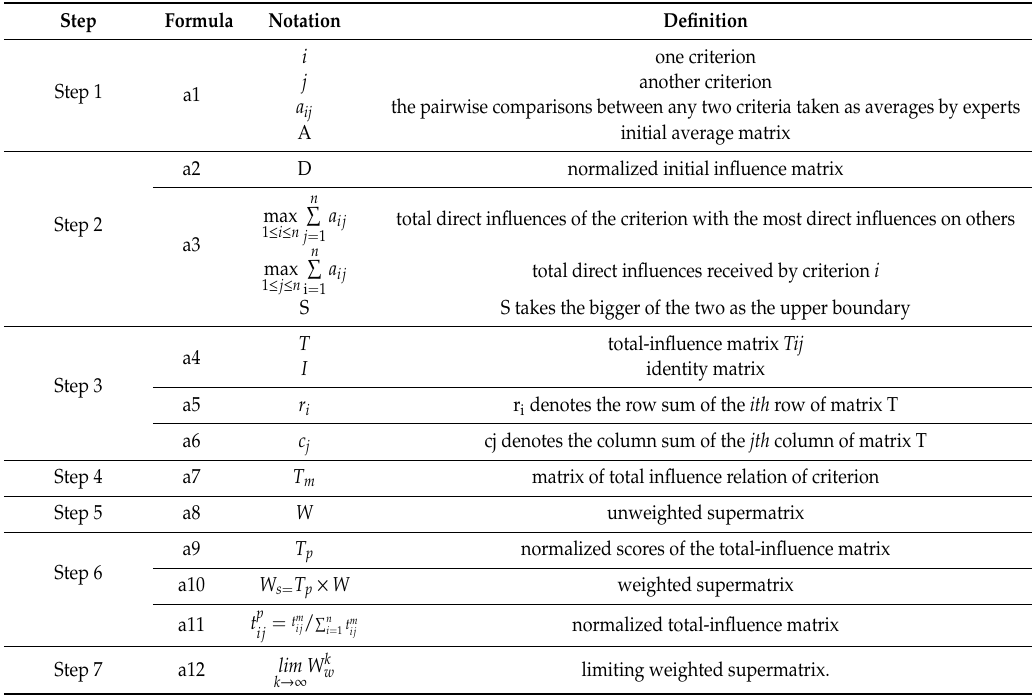
Table 1. Definitions of the notations of the integrated Decision Making Trial and Evaluation Laboratory (DEMATEL) and Analytic Network Process (ANP) method.